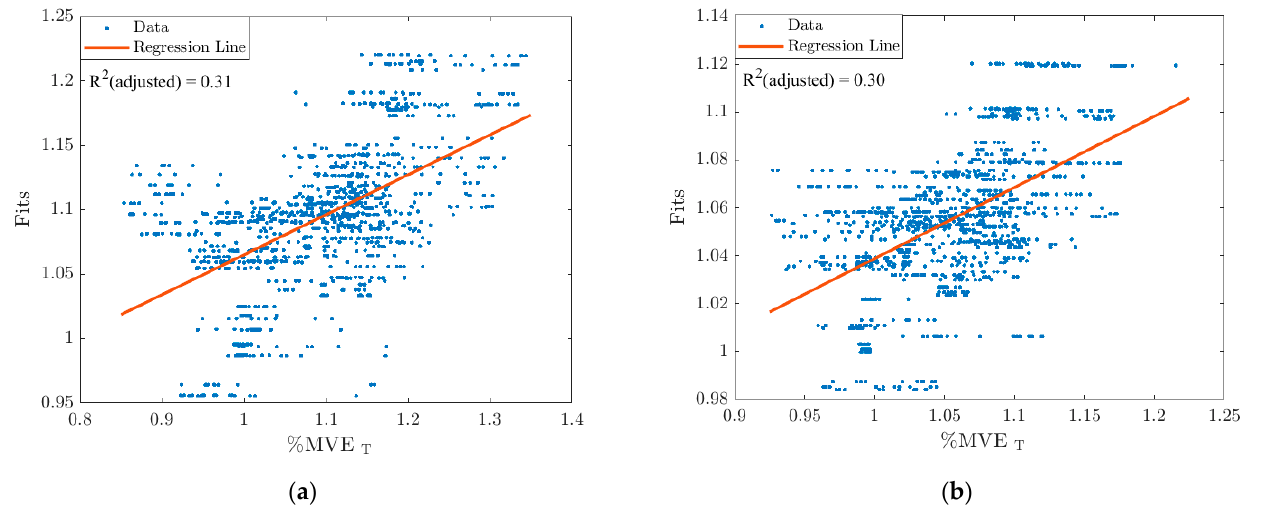
Figure 4. Fits vs. %MVE T (transformed % maximum voluntary electrical activation data) ( a ) before and ( b ) after back muscle fatigue from the stepwise regression models of the internal oblique (IO). Table 4. Stepwise regression models for %MVE T (transformed % maximum voluntary electrical activation data) of the internal oblique pre-and post-back muscle fatigue, where mass, height, and body mass index (BMI) are continuous pre- dictors, and vibration frequency is a categorical predictor.